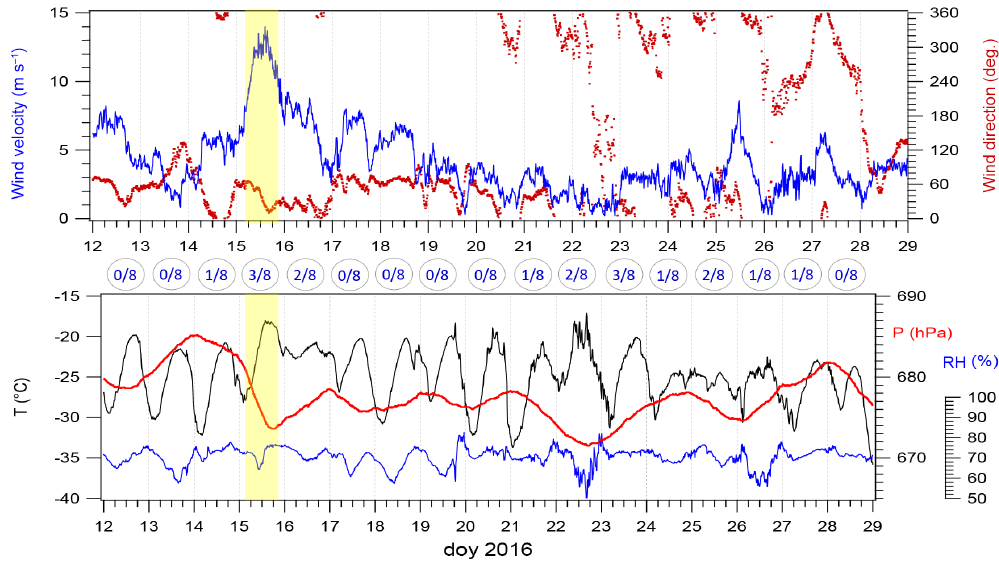
Figure 4. Time series of the measured meteorological parameters in 2016 (60s temporal resolution). The stormy period LPS16 is shaded in yellow. Again, the cloud amount is denoted on the top of the second